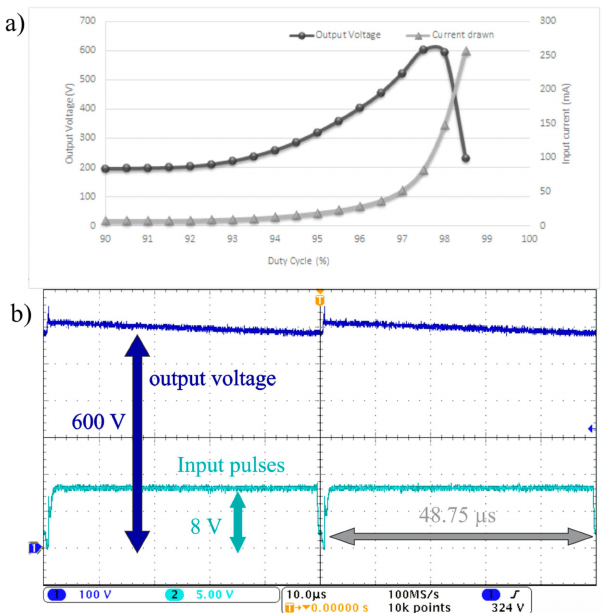
( b ) The output voltage waveform (Dark Blue) and the switching pulses waveform